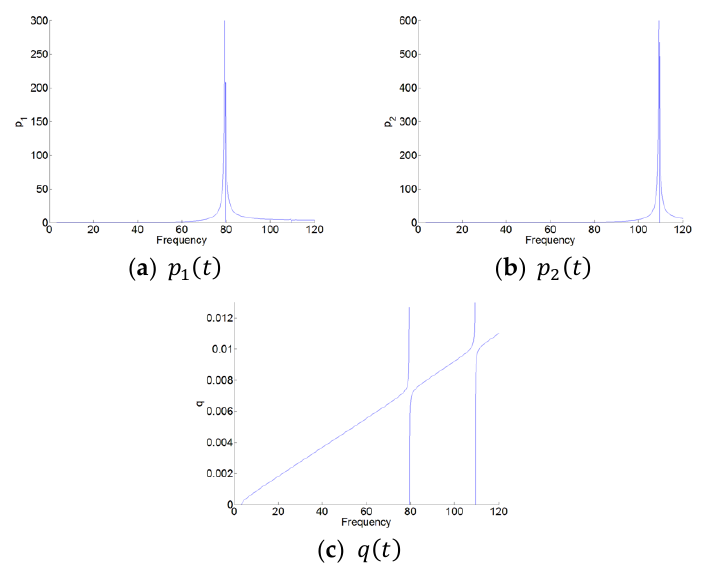
Figure 7. The nonlinear normal modes (NNMs) of the system-amplitudes. ( a ) 𝑝 1 (𝑡) , ( b ) 𝑝 2 (𝑡) , and ( c ) 𝑞(𝑡) .